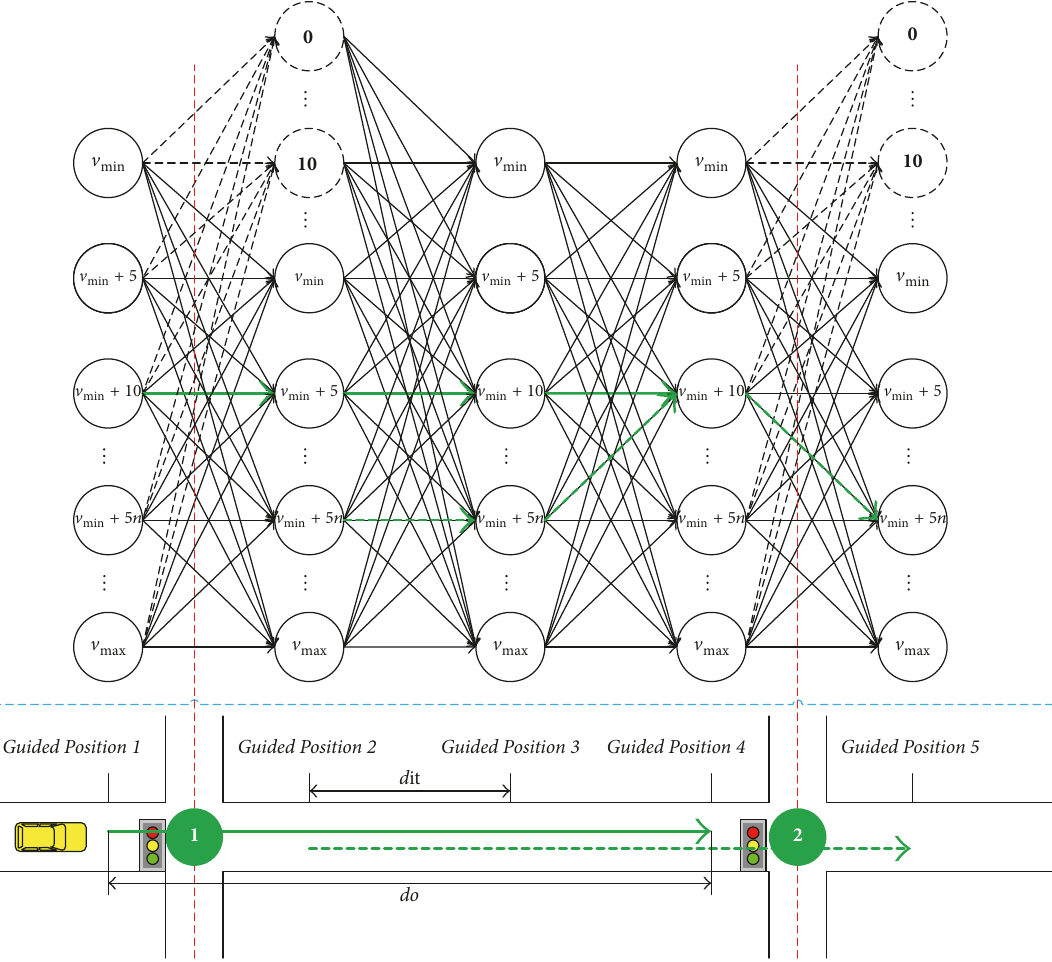
Figure 2: The DESGS calculation using